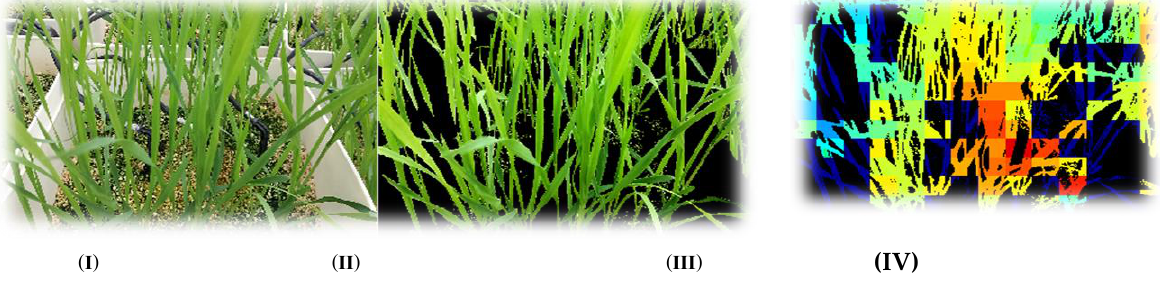
Figure 1. Wheat in greenhouse: ( I ) original photo, ( II ) after preprocessing, ( III ) The empty space represents a large number of layers each layer contain a machine learning with Artificial Neural Network; and ( IV ) N percent map. A scale that includes artificial colors. The scale of the artificial colors is a gradual change in %N from low blue to high red and the average of the field ± its standard deviation. Schematically: Blue goes from 0 – 2%, yellow 2 – 3.5%, red = 3.5 – 5% (average 3.1 ± 0.6). Treatment received N amount corresponding to 120 kg/ha.